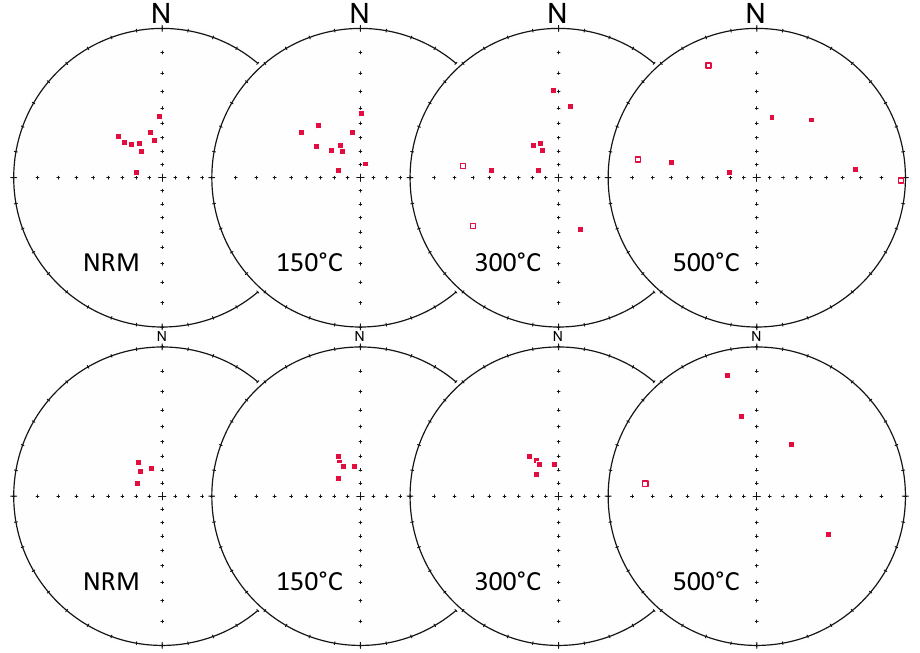
Figure 5. Examples of the loss of well-defined paleomagnetic signal (NRM: individual directions in the natural state) in the “cold” Eger-Ipolytarnóc ignimbrite, as documented by the increasing scatter of the directions from 150 °C in the ignimbrite immediately above the ‘footprint’ sandstone (upper row) and after 300 °C in the massive ignimbrite of the Borókás Ditch (lower row), both at Ipolytarnóc. Normal (full symbols) and reversed (empty symbols) polarity directions are plotted in stereographic projections. Analyses performed on samples from Márton et al. (2007) 12